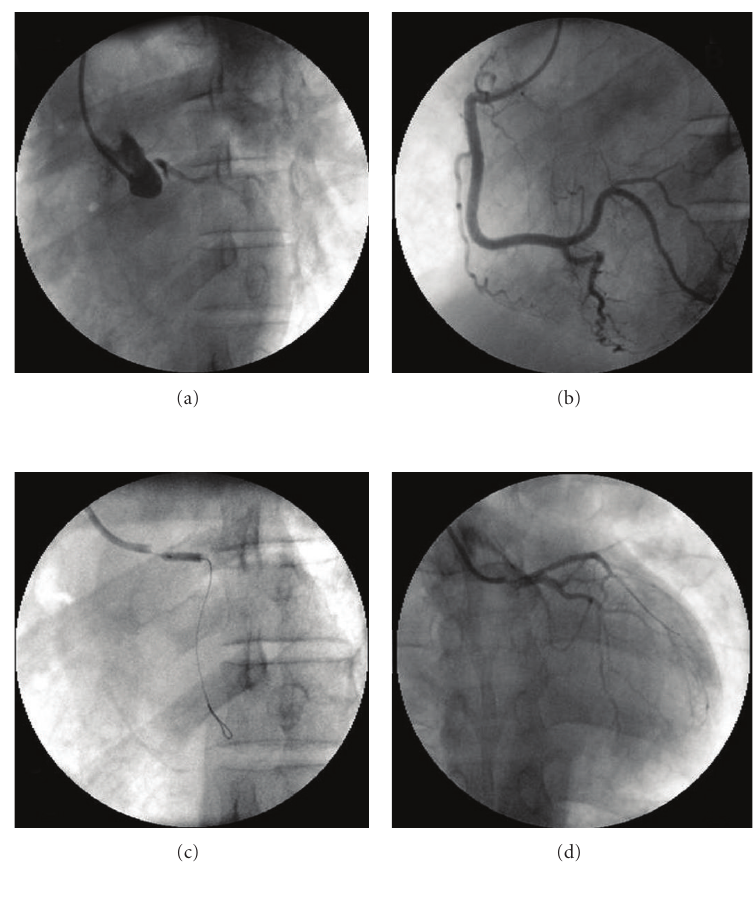
Figure 2: Coronary angiogram showing: (a) a suboccluded ostial lesion of left main coronary artery; (b) a normal right coronary artery; (c) balloon inflation and stent release during the percutaneous coronary intervention; (d) final result with angiographic